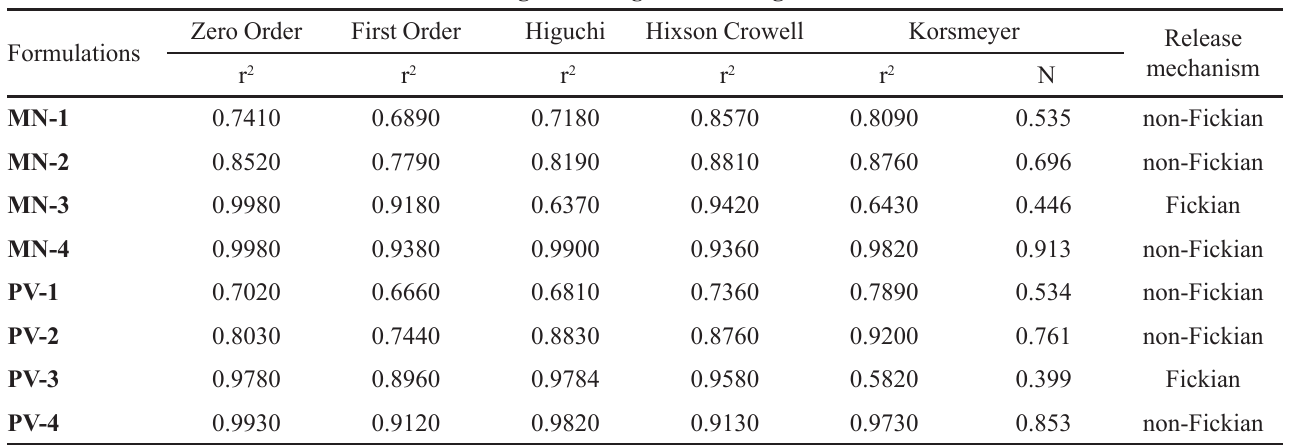
TABLE VII - In vitro release kinetics of diclofenac sodium